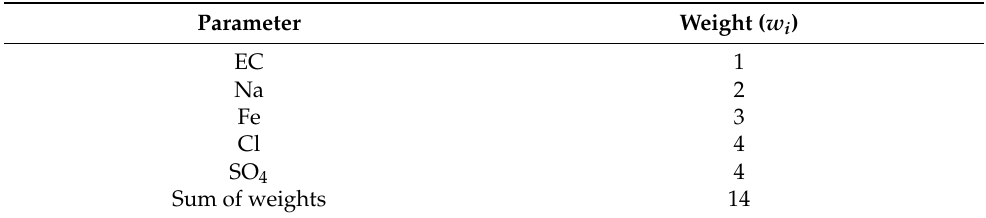
Table 2. Weights of parameters required to calculate Landfill Water Pollution Index (LWPI)